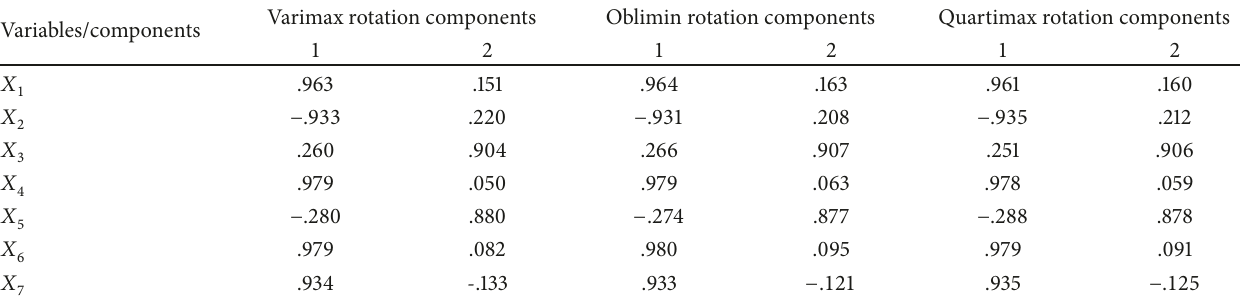
Table 2: Rotation of components.